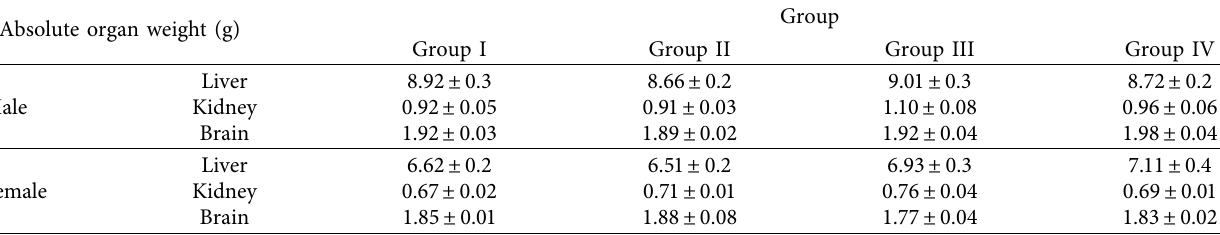
Table 3: Organ weight of rats treated with leaf extract of R. prinoides .